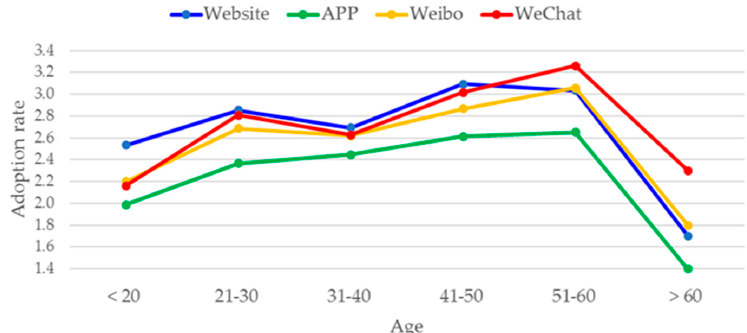
Figure 3. Age and adoption of local e-government services.